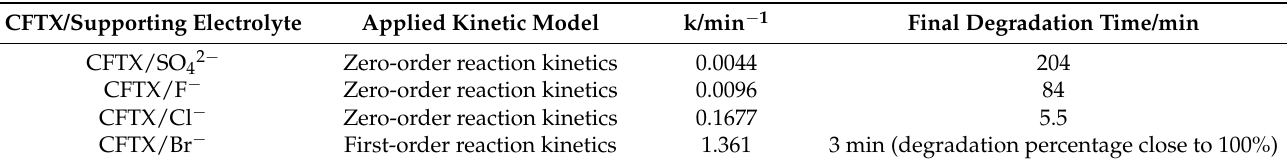
Table 2. Kinetic data for CFTX degradation reaction in different supporting